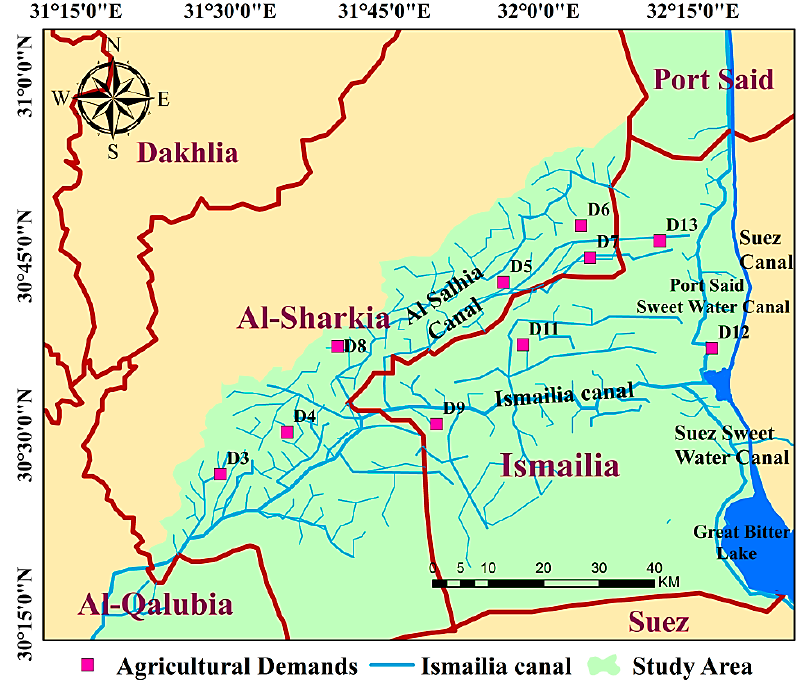
Figure 12. Location of DEMs which benefit from reused drainage